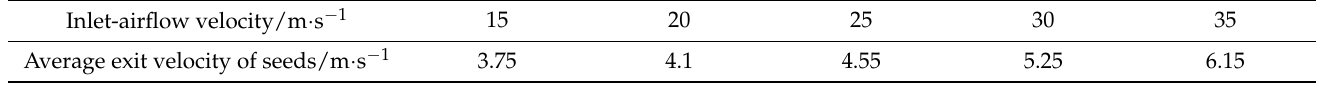
Table 4. Average ejection velocity of seeds under different inlet-airflow